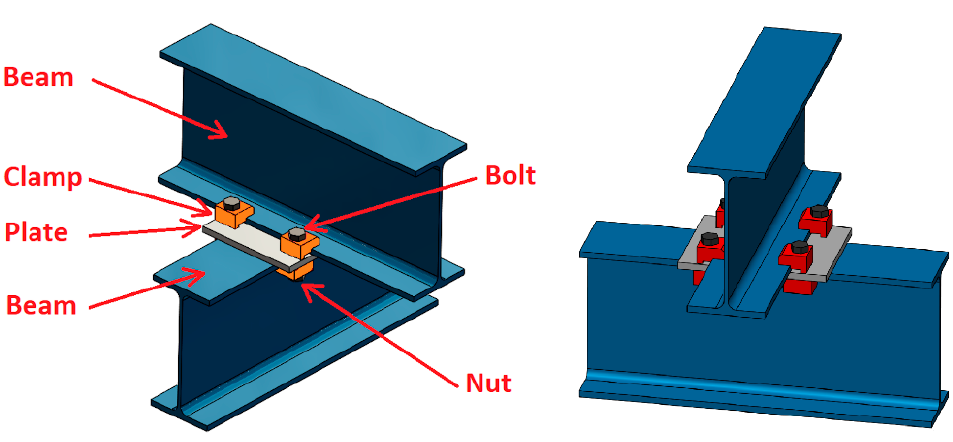
Figure 1. Example of clamped joint with its component elements. Clamp joints are fundamentally composed of a clamp, a bolt, and a nut, which are employed to join two beams or a plate (previously drilled) to a beam (Figure 1). With this type of joint, any type of previous operation on a profile with flanges is not necessary. There are several clamp types and manufacturers [4–6]. Clamp dimensions may differ between different models, but the lengths of the front lever and the rear lever mainly determine the clamp